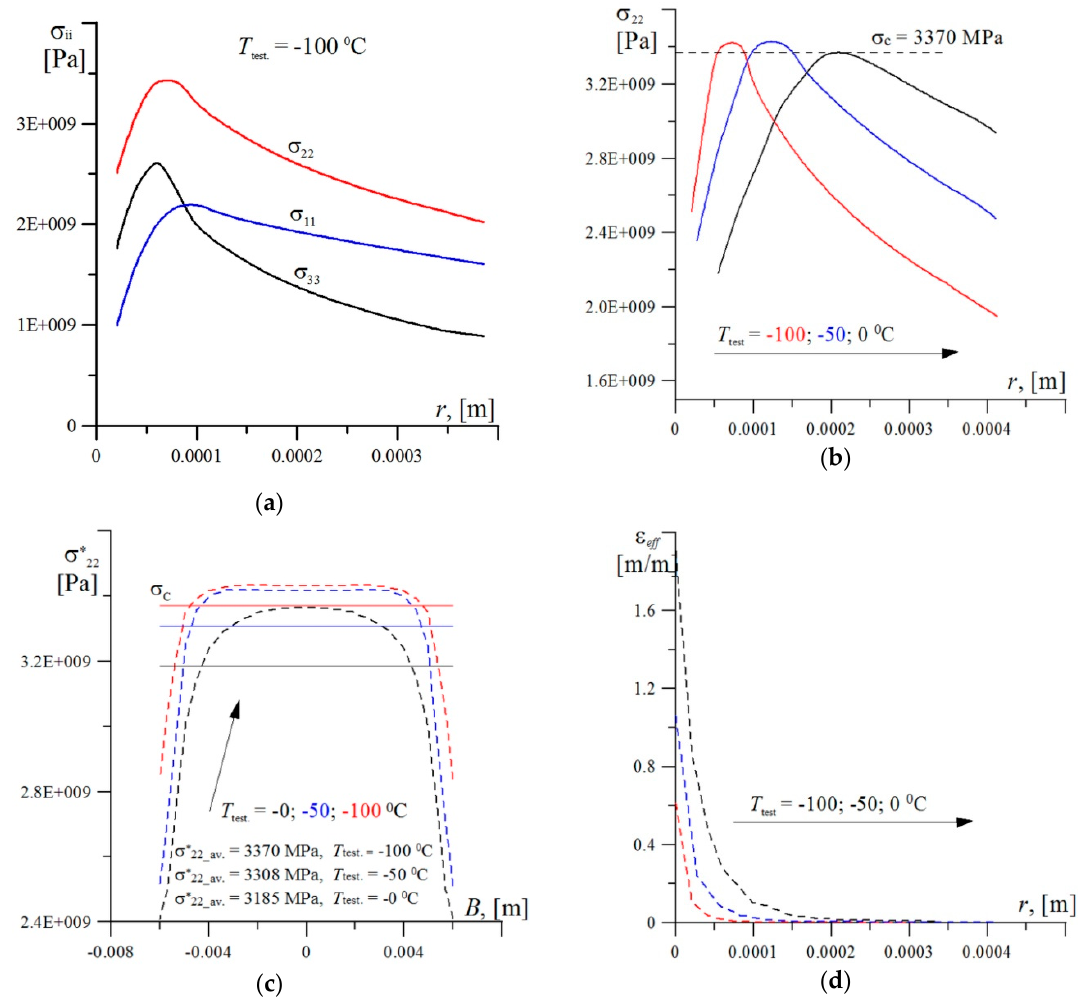
Figure 9. ( a ) The distributions of stress components before crack tip at T test. = − 100 °C; ( b ) the distributions of the opening stress σ 22 at different test temperature; ( c ) the distributions of max values σ * 22 through thickness; ( d ) the strain distributions at test temperatures.